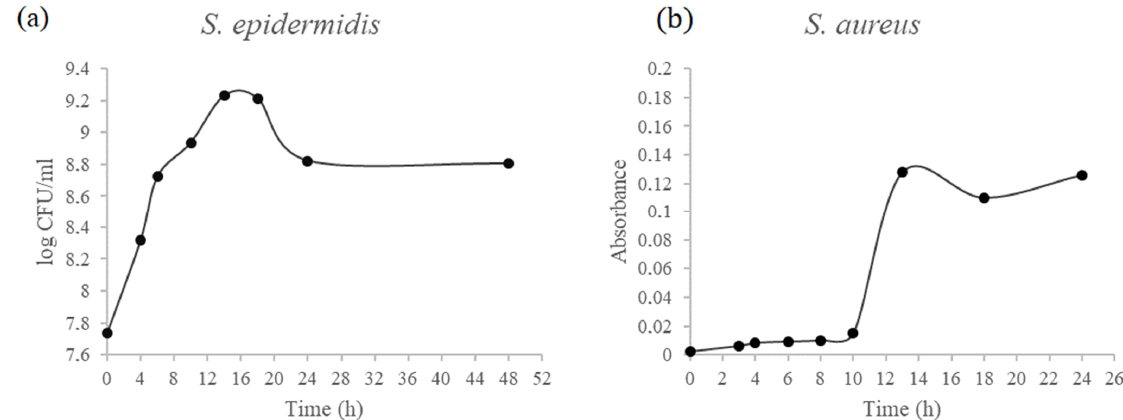
Figure 3. Zeta potentials of orthotic and prosthetic material surfaces.